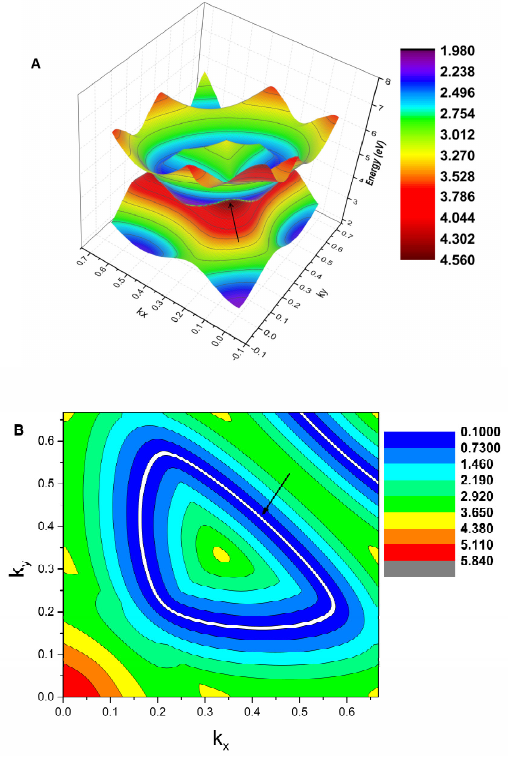
Figure 6. ( A ) The 3D band dispersion around the K point in the k z = 0 plane. The white line shows the profile of the nodal line. ( B ) The 2D shape of the K-centered nodal line in the k z = 0 plane (highlighted by the white line and indicated using an arrow).